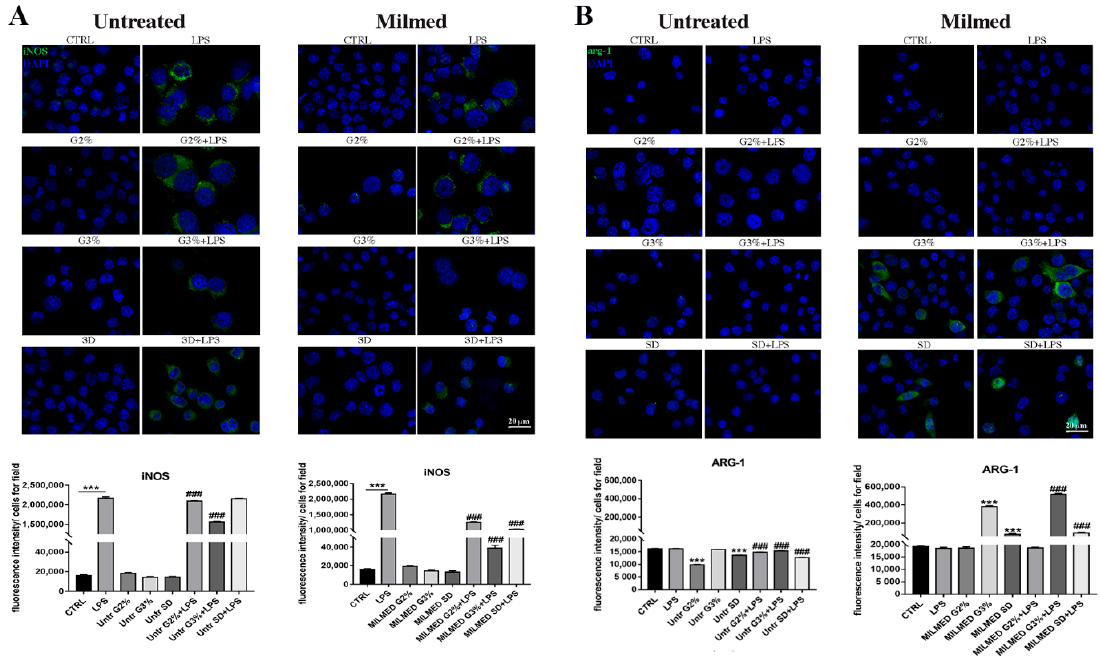
Figure 2. ( A ) Immunofluorescence analysis of Inducible Nitric Oxide Synthase (iNOS) expression in BV-2 cells cultured in the presence of untreated yeast grown for 24 h in different metabolic medium without LPS (on the left, first column) or after addition of Lipopolysaccharide (LPS) 1 ng/mL (second column) and ( B ) Arginase-1 (ARG-1)expression in BV-2 cells cultured in the presence of Milmed grown in different metabolic medium without LPS (on the right, first column) or after addition of LPS 1 ng/mL (second column). Quantification of the median fluorescence intensity was performed by ImageJ software and data were expressed as histograms, normalized to the number of cells for field . 4 ′ ,6-diamidino-2-phenylindole ( DAPI)was used to counterstain the nuclei. Data are expressed as mean ± SD for each group (n = 3). Statistical analysis was performed by the one-way analysis of variance (ANOVA) coupled with the Bonferroni post-test. *** p < 0.001; ### p < 0.001.